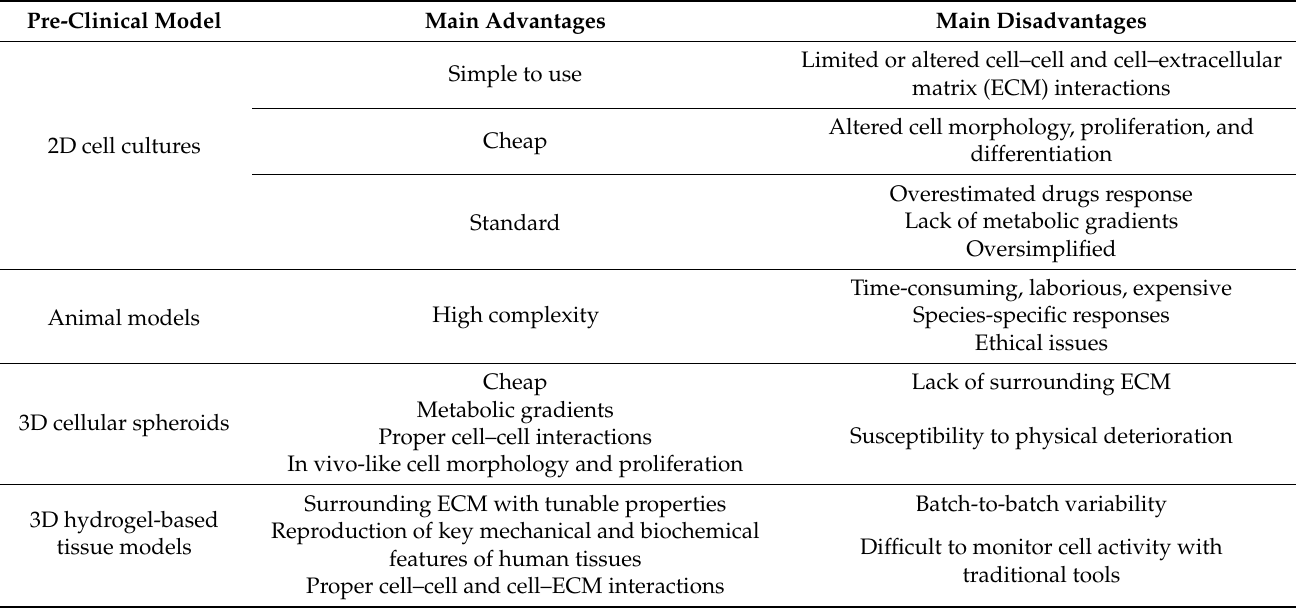
Table 1. Main advantages and disadvantages of the main pre-clinical tissue